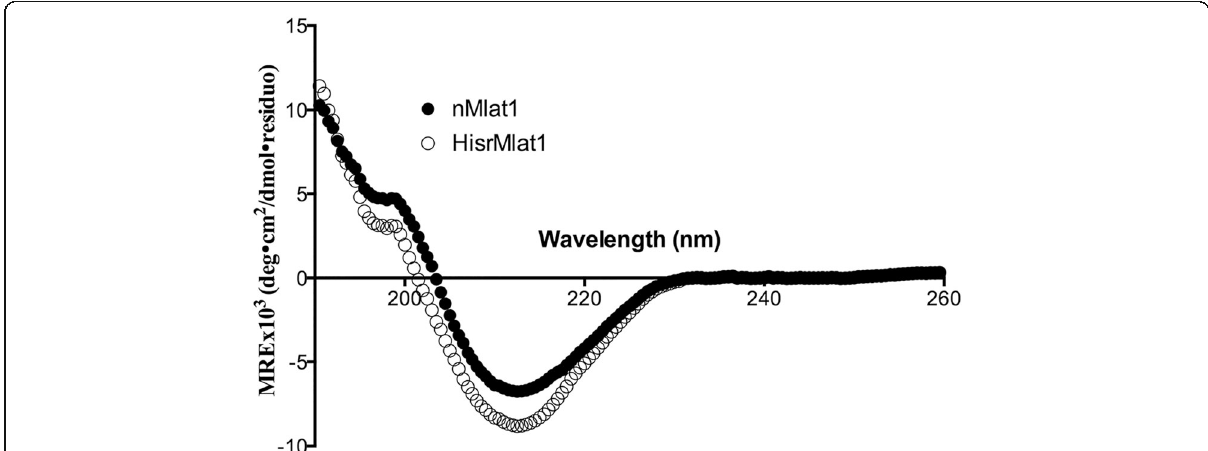
Fig. 4 Circular dichroism of native nMlat1 and recombinant HisrMlat1. Secondary structural analysis showed 4.7 and 9.7 % of α helix and 35.3 and 30.0 % of β strand for nMlat1 and HisrMlat1,